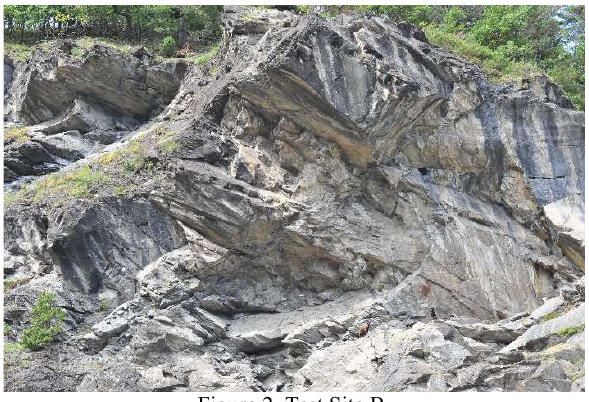
Figure 2. Test Site B.